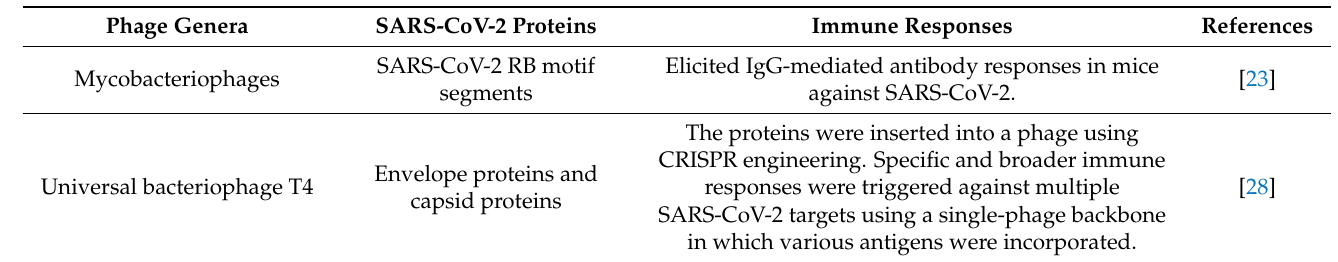
Table 2. Overview of phage-based vaccines/immunizations for COVID-19 that use different proteins of SARS-CoV-2 in different genera of